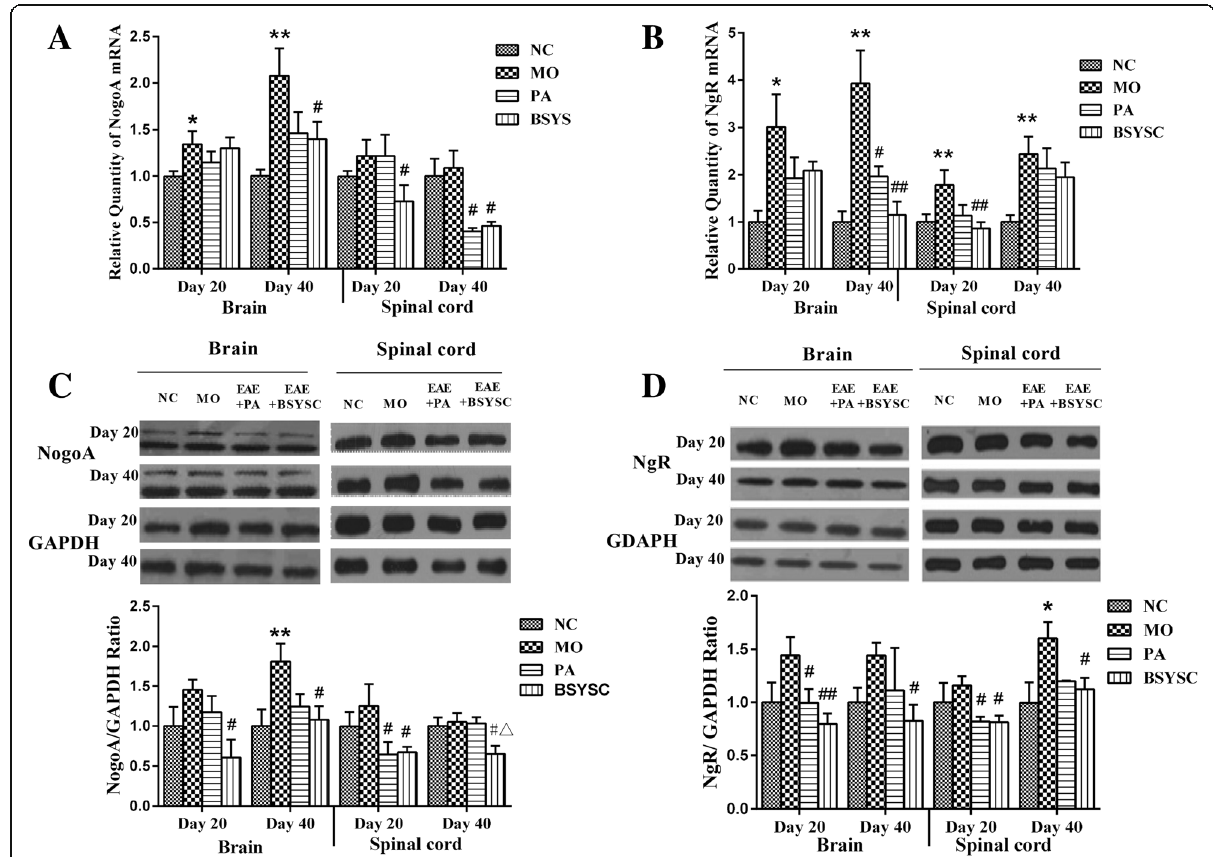
Fig. 6 Expressions of mRNA and protein of NogoA and NgR in the brain and spinal cord of mice treated with or without BSYSC 20 and 40 dpi. Expression of NogoA and NgR mRNA and protein had suffered different degrees of decrease in BSYSC group. The mRNA levels of NogoA ( a ) and NgR ( b ) were detected by qRT-PCR analyses. The protein levels of NogoA ( c ) and NgR ( d ) were measured by Western blot and quantified using GAPDH as the loading controls. Data are expressed as means ± SE, n = 5 for each group. * p < 0.05, ** p < 0.01 vs. NC; # p < 0.05, 5, ## p < 0.01 vs. MO; △ p < 0.05 vs.